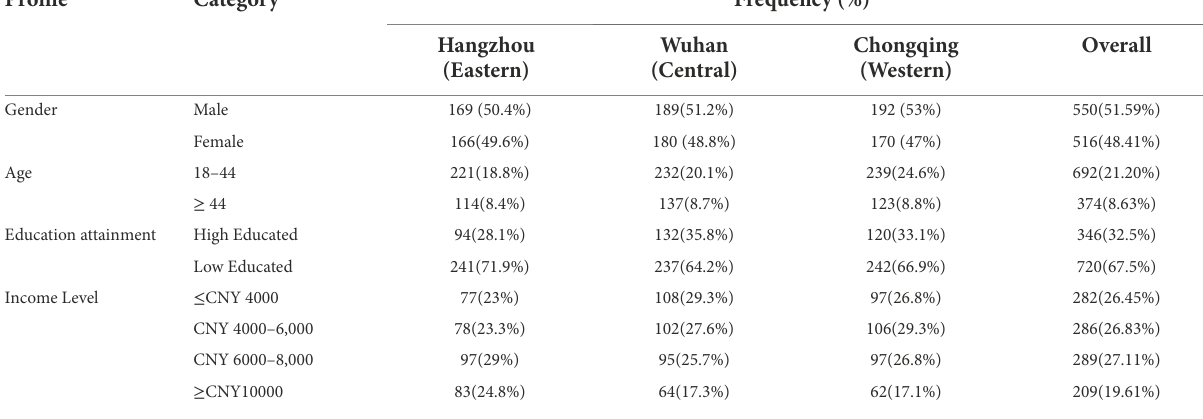
TABLE 1 Demographic characteristics of the respondents.